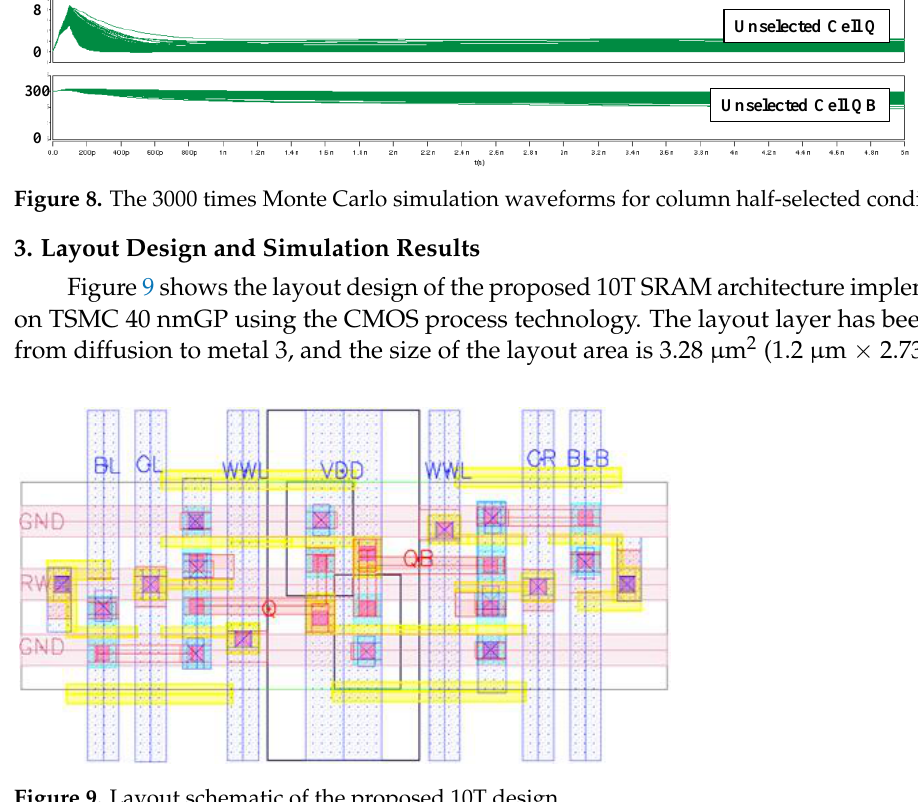
Figure 9. Layout schematic of the proposed 10T design.